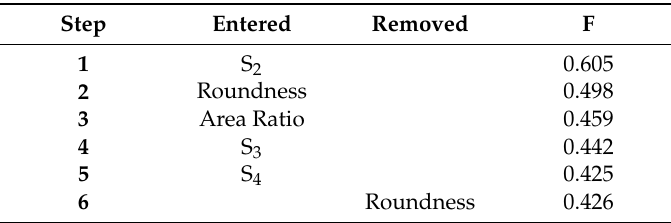
Table 3. Summary of shape features by discriminant